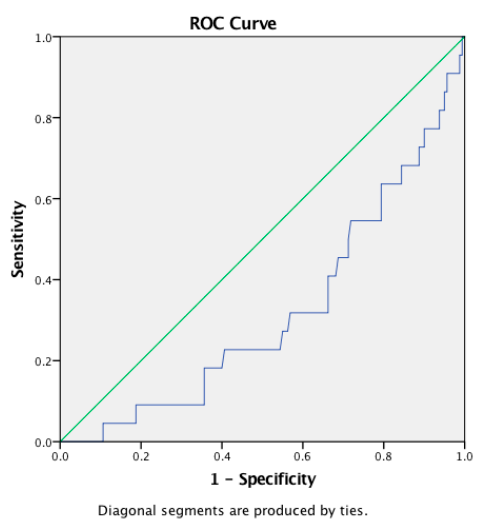
Figure 2. ROC curve of LMR.